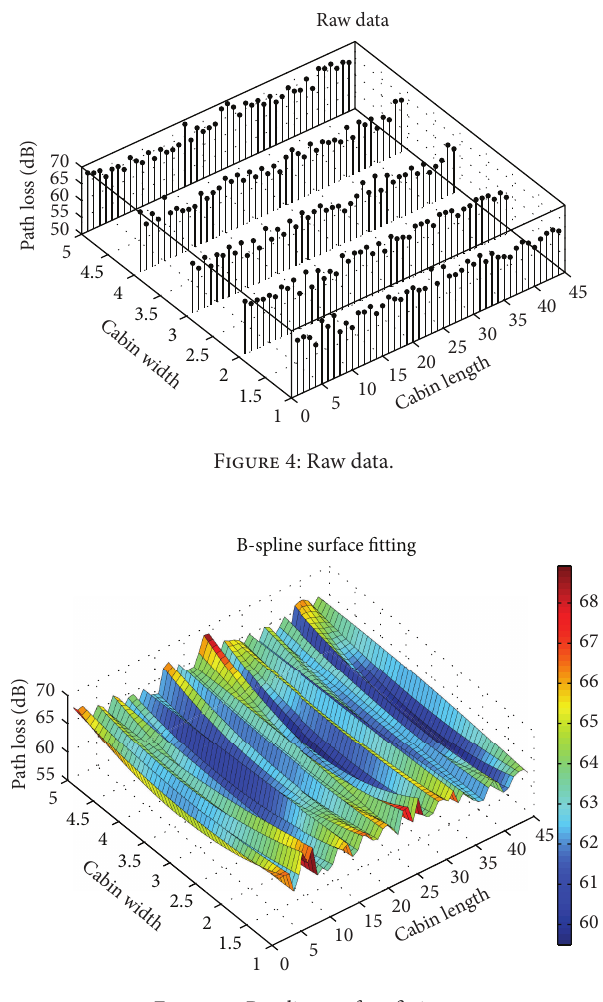
Figure 5: B-spline surface fitting.